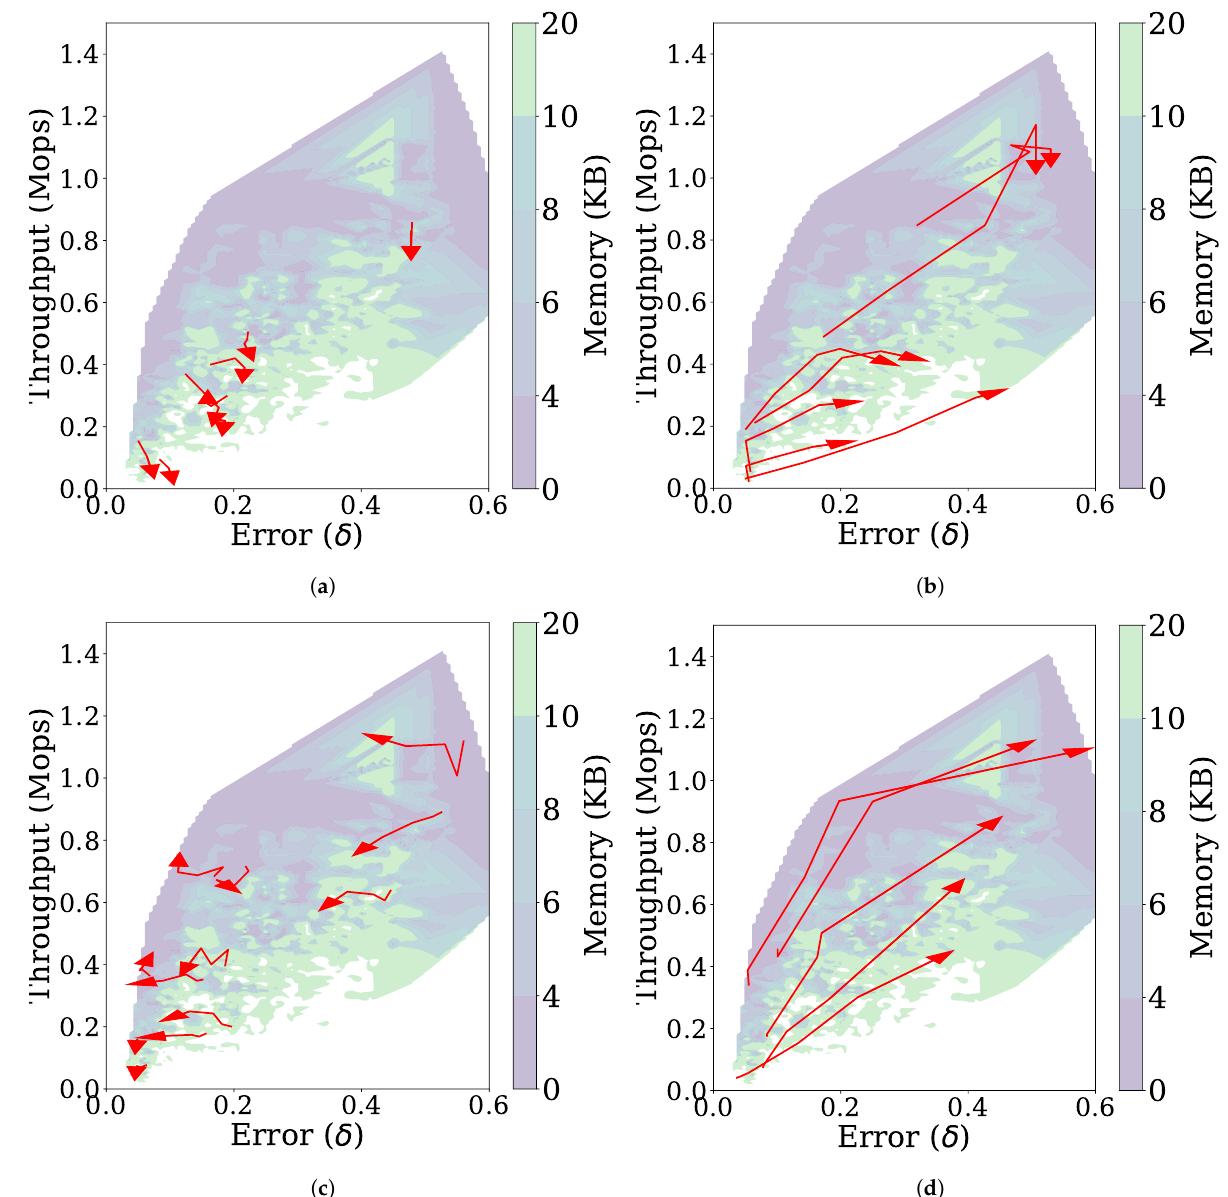
Figure 12. Trajectories (represented by red arrows) of the performance of FlexSketch for the non-stationary data stream with incremental concept drift as the value of each parameter increases. ( a ) N M ( b ) N Q ( c ) λ ( d ) γ